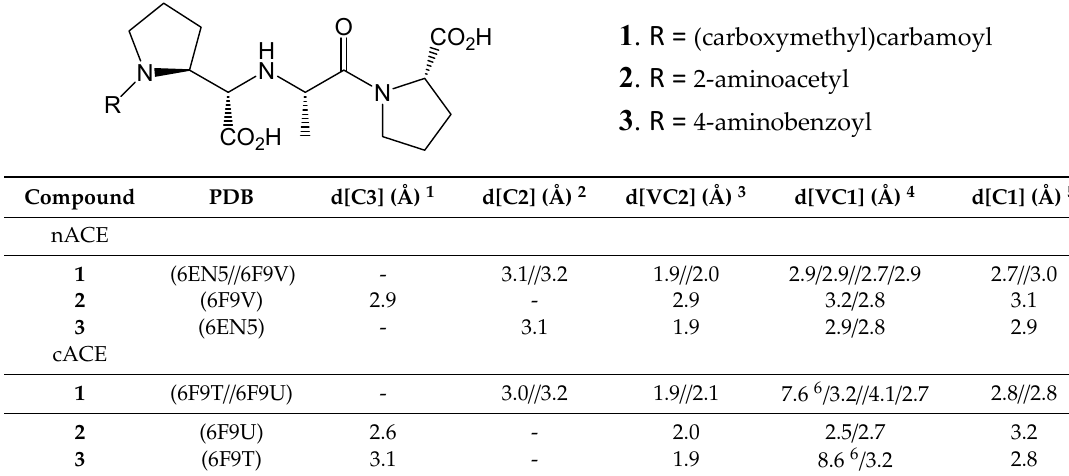
Figure 3. Constraints proposed for ACE inhibitors. C1, C2 and C3 are the constraints defined for docking experiment. VC1 and VC2 are constraints subsequently detected by visual inspection. Table 1. ACE-ligand HB distances for poses obtained from Glide docking using constraints C1 and C2 (or C3).